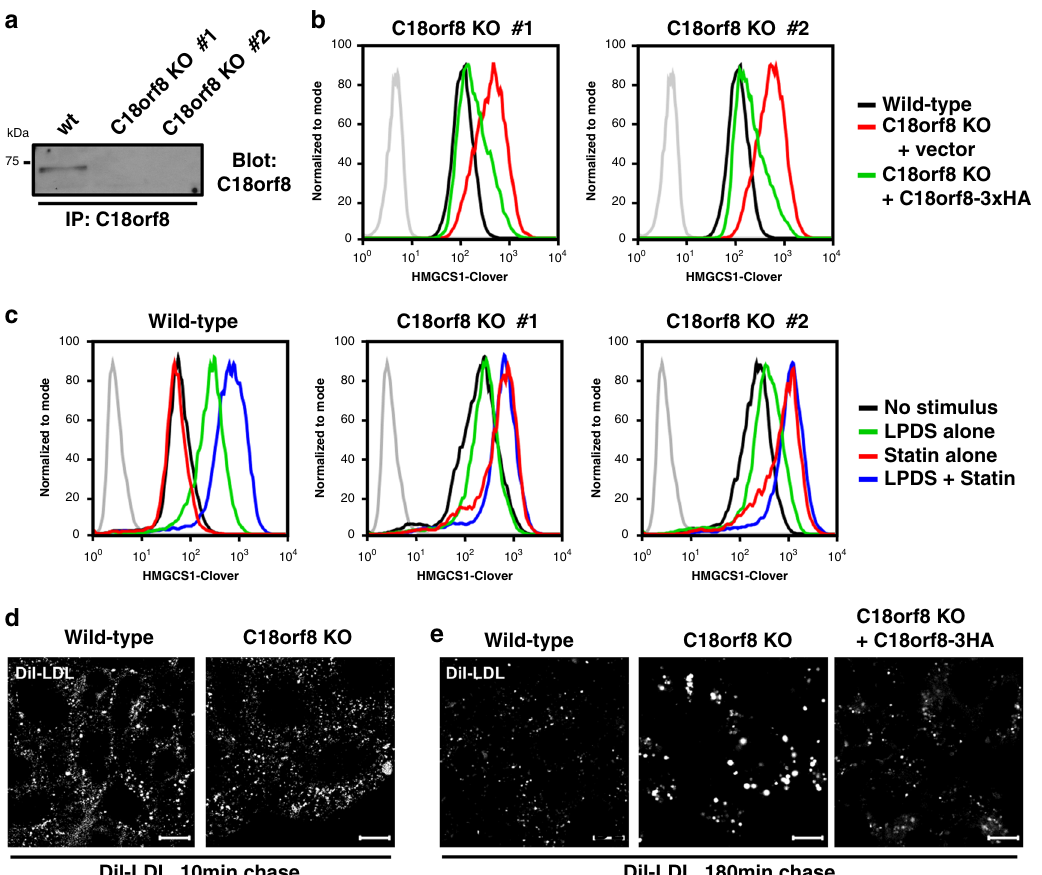
Fig. 3 C18orf8 is required for endosomal LDL-cholesterol uptake. a , b C18orf8 -de fi cient cells show spontaneous cholesterol de fi ciency. a Wild-type and C18orf8 -de fi cient clones were lysed, endogenous C18orf8 immunoprecipitated, and detected by a C18orf8-speci fi c antibody. b C18orf8 -de fi cient HMGCS1- Clover clones were transduced with HA-tagged C18orf8 (C18orf8-3xHA; green lines) or empty vector (red lines) and HMGCS1-Clover expression was determined by fl ow cytometry at day 18 using wild-type HMGCS1-Clover cells as a control (black lines) (three independent experimental replicates). c C18orf8 -de fi cient cells are dependent on endogenous cholesterol biosynthesis. Wild-type and C18orf8 -de fi cient HMGCS1-Clover cells were either cultured in LPDS to block exogenous LDL-cholesterol uptake (green lines), treated with mevastatin to block endogenous cholesterol biosynthesis (red lines), or a combination of both treatments (blue lines), after which cells were analysed by fl ow cytometry for HMGCS1-Clover expression. d , e C18orf8 -de fi cient cells show defective endo-lysosomal LDL degradation. Wild-type, C18orf8 -de fi cient or C18orf8 -de fi cient cells complemented with C18orf8-3xHA were starved for 1 h and pulse-labelled with fl uorescent Dil-LDL, incubated for 5 min ( d ) or 180 min ( e ), fi xed and visualised by confocal microscopy. Exposure times were kept constant between individual conditions at given time points. Representative images are shown from fi ve fi elds per condition. Scale bars = 10 µ endo-lysosomal degradation that affects both LDL and EGF and results in their reliance on de novo cholesterol biosynthesis for cholesterol supply.